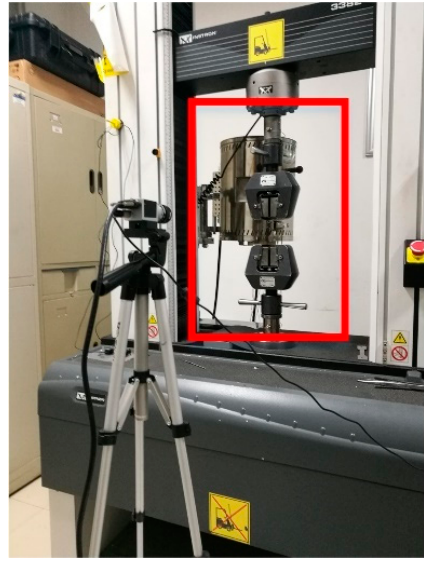
Figure 4. Experimental equipment (INSTRON 3382, INSTRON).